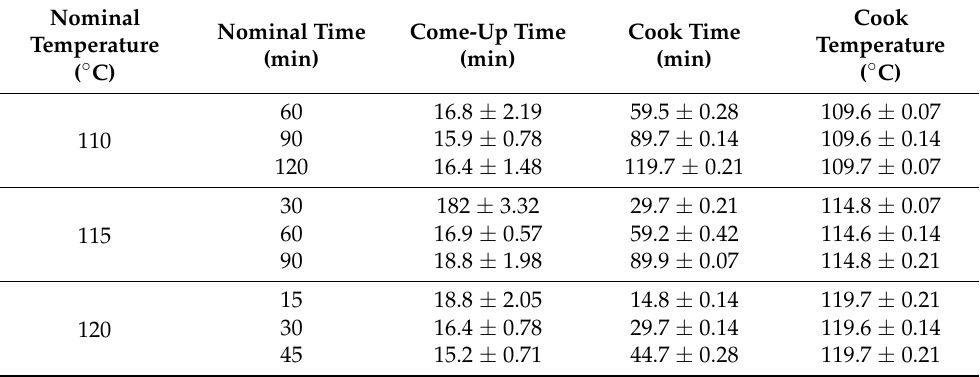
Table 3. Nominal and observed values of processing time and temperatures of soy slurry (5%) and the come-up times associated with different thermal